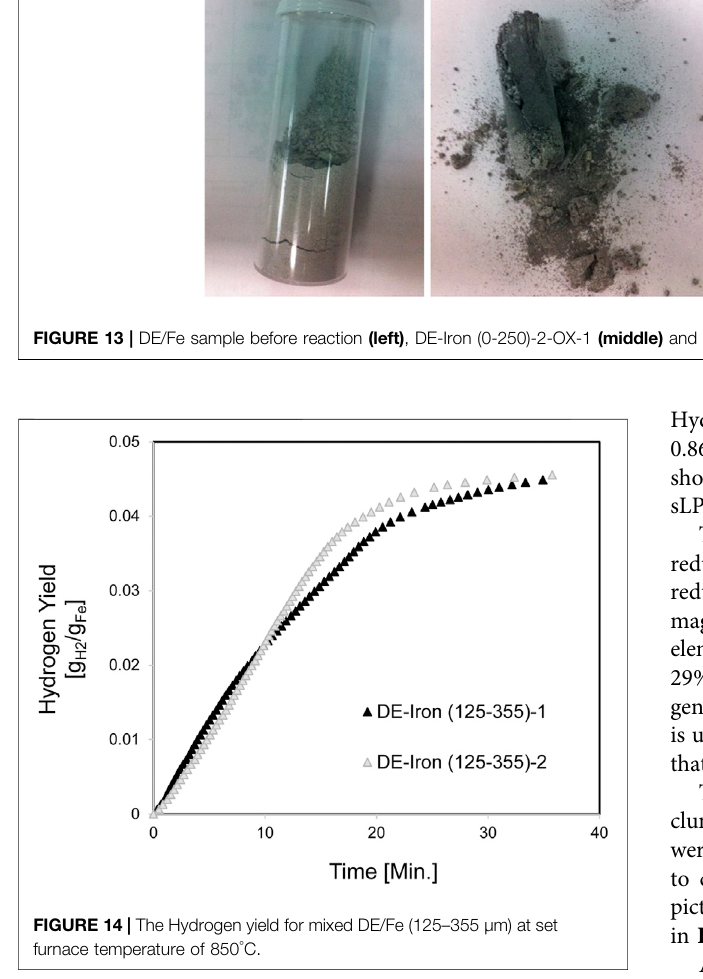
Frontiers in Chemical Engineering |